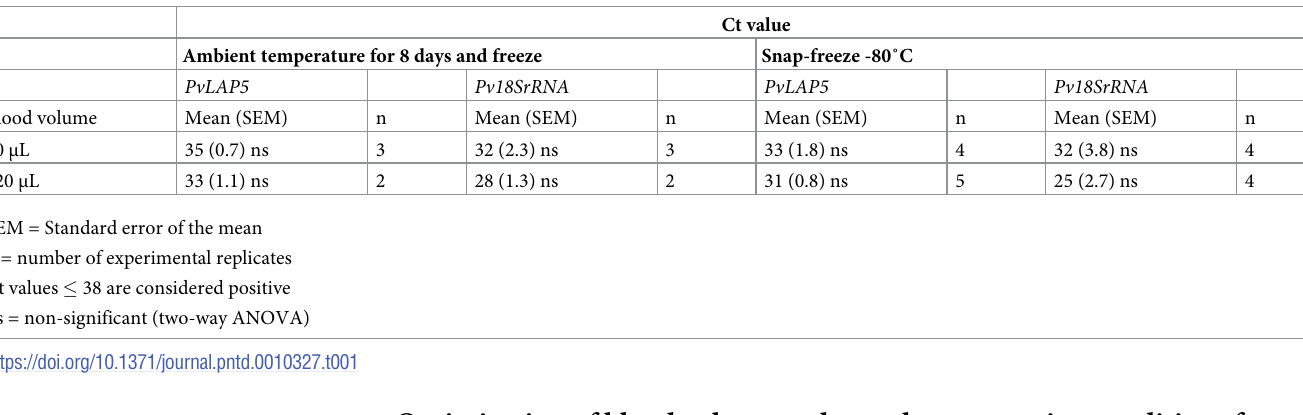
Table 1. qRT-PCR Ct values of two blood volumes of Plasmodium vivax infected blood preserved with RNAprotect and kept at ambient temperature for eight days or snap-freeze at – 80˚ Celsius.